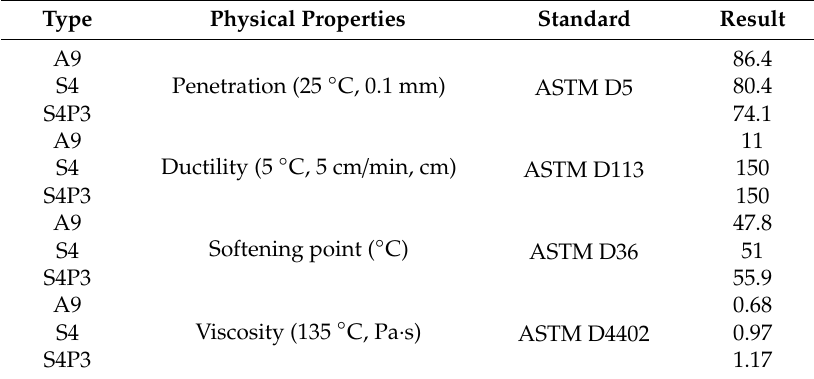
Table 1. Physical properties of base asphalt.